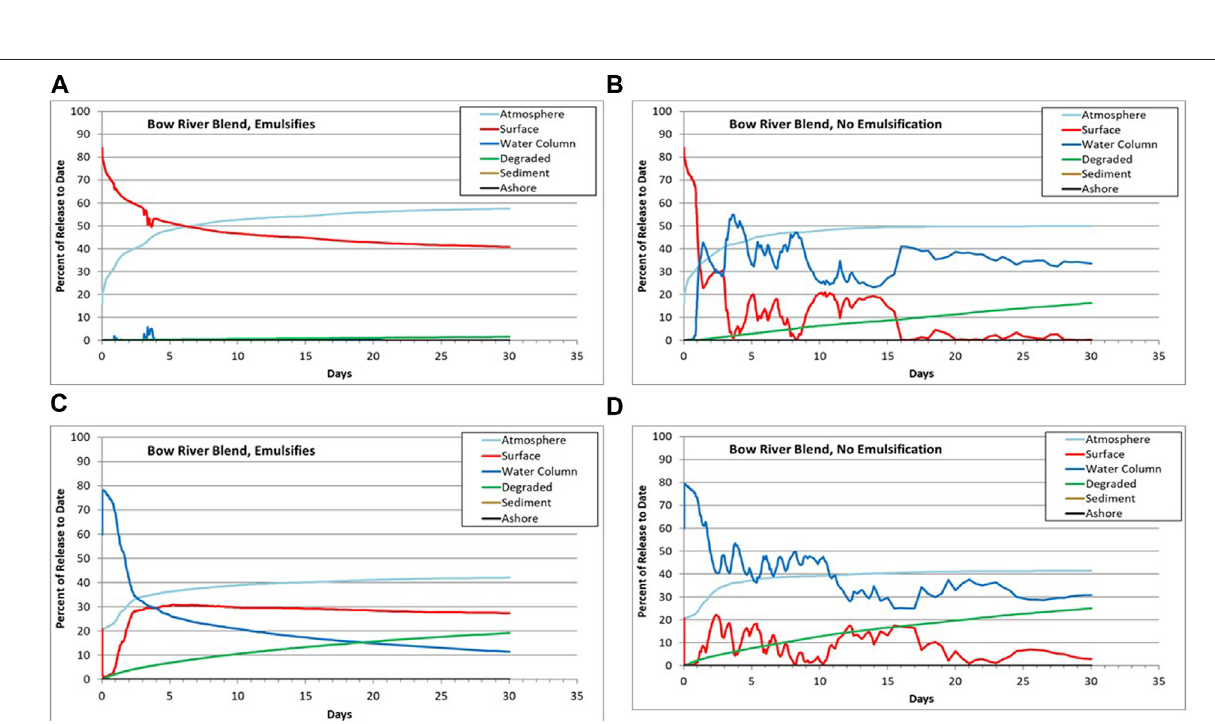
Frontiers in Environmental Science |